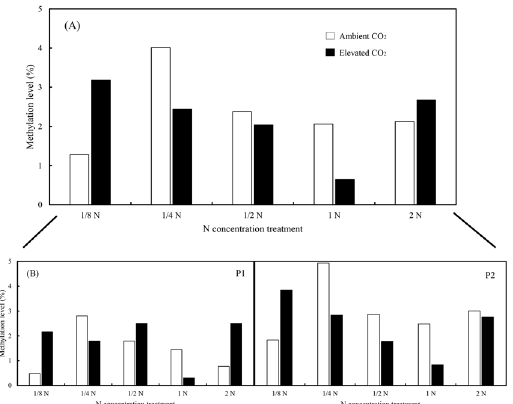
Figure 6. The cytosine methylation of fused Cry 1Ab/Ac transgene in leaves of transgenic Bt rice grown under ambient and elevated CO 2 with different N-fertilizer rates. (n = minimum of 10 clones for each treatment; ( A ) Percentage methylation of the fused Cry 1Ab/Ac transgene (both two fragments); ( B ) Percentage methylation of P1 and P2 fragments in the fused Cry 1Ab/Ac transgene, respectively).